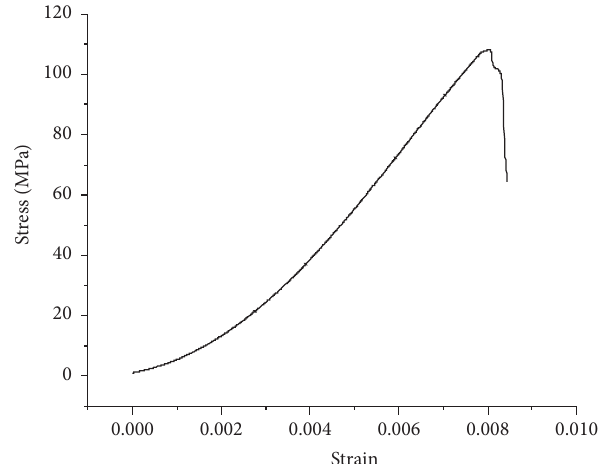
Figure 12: Stress-strain curve of granite samples.